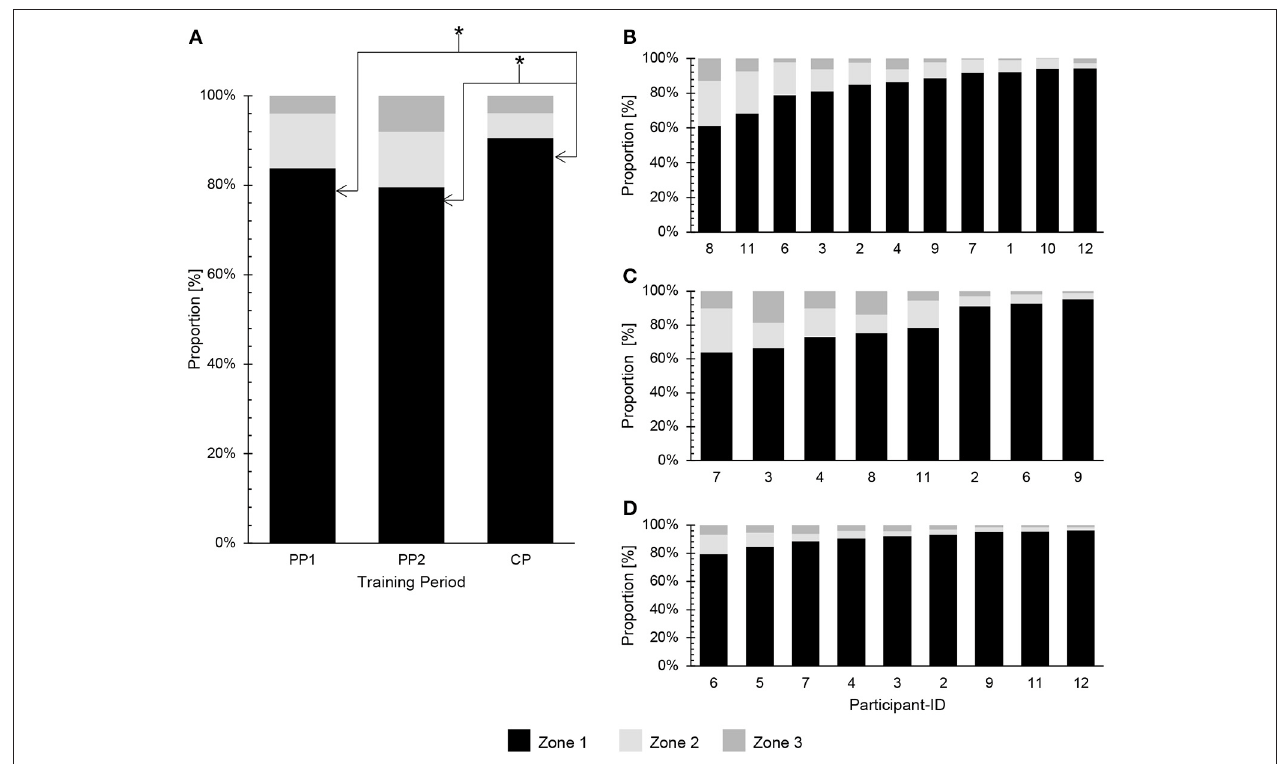
FIGURE 3 | Percentage distribution of training intensity during the three periods. (A) Group mean during PP1, PP2 and CP. (B) Individual values during PP1. (C) Individual values during PP2. (D) Individual values during CP. *Significant difference with respect to the percentage of time spent in Zone 1 between PP1 and CP ( p < 0.01), as well as between PP2 and CP ( p = 0.03).